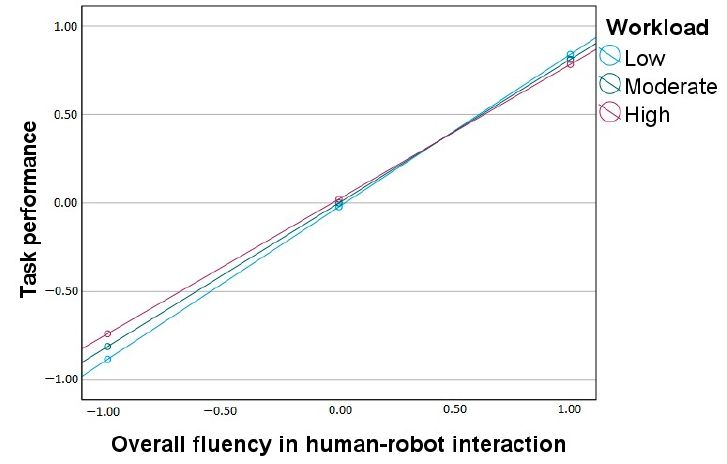
Figure 1. Workload as a moderator between overall fluency in human-robot interaction and task performance.